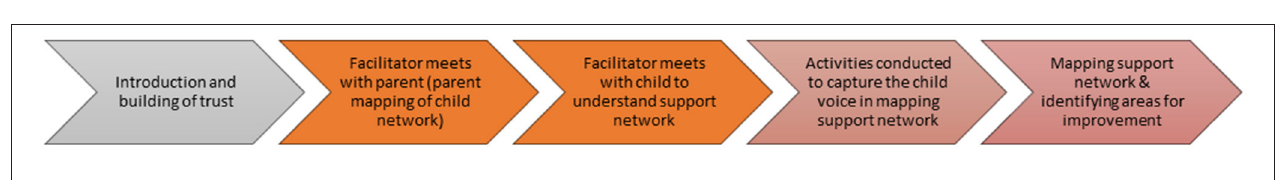
FIGURE 5 | Practical elements of CVA Phase 1.